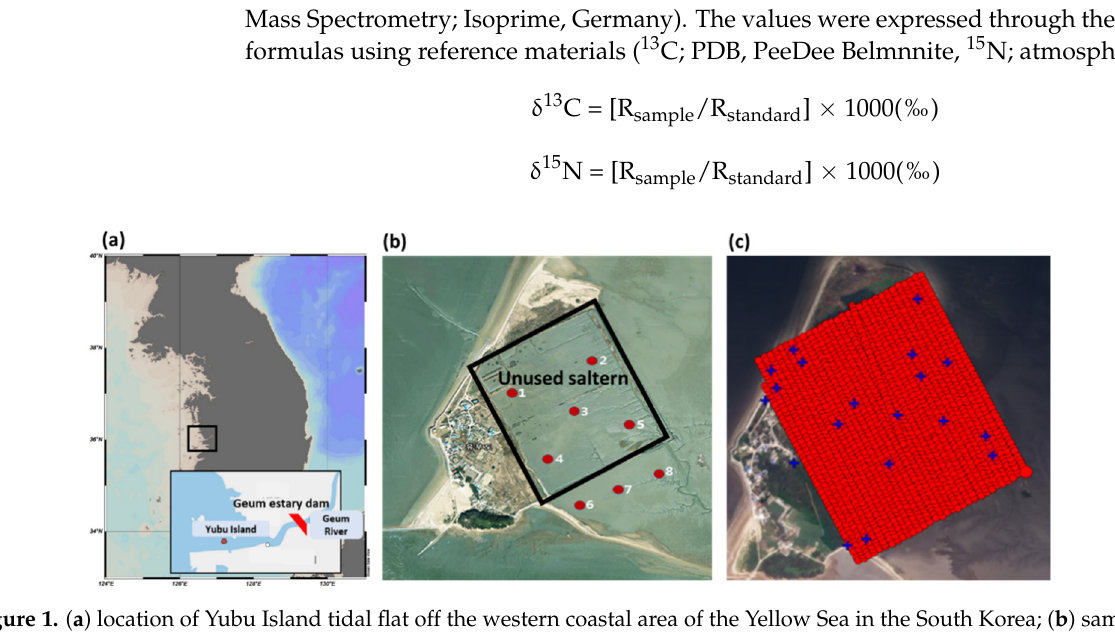
Figure 1. ( a ) location of Yubu Island tidal flat off the western coastal area of the Yellow Sea in the South Korea; ( b ) sampling sites; ( c ) the locations of GCP (blue x signal) and points of drone photos (red dots).